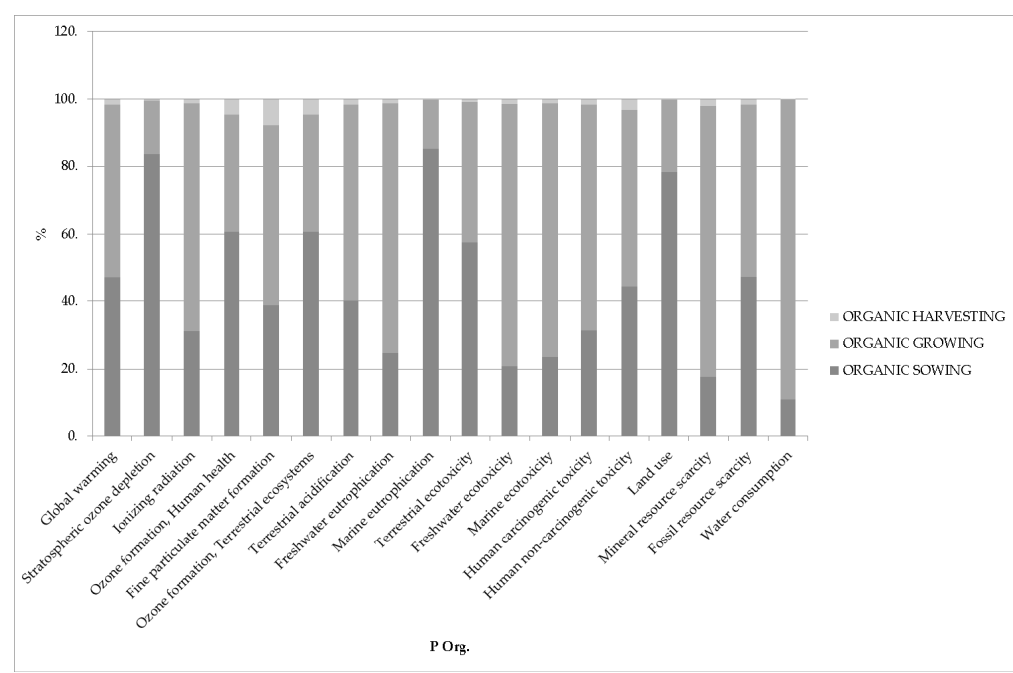
Figure 6. Environmental impact per kg of early potato with conventional method, per impact cate- gory and main cultivation operations .